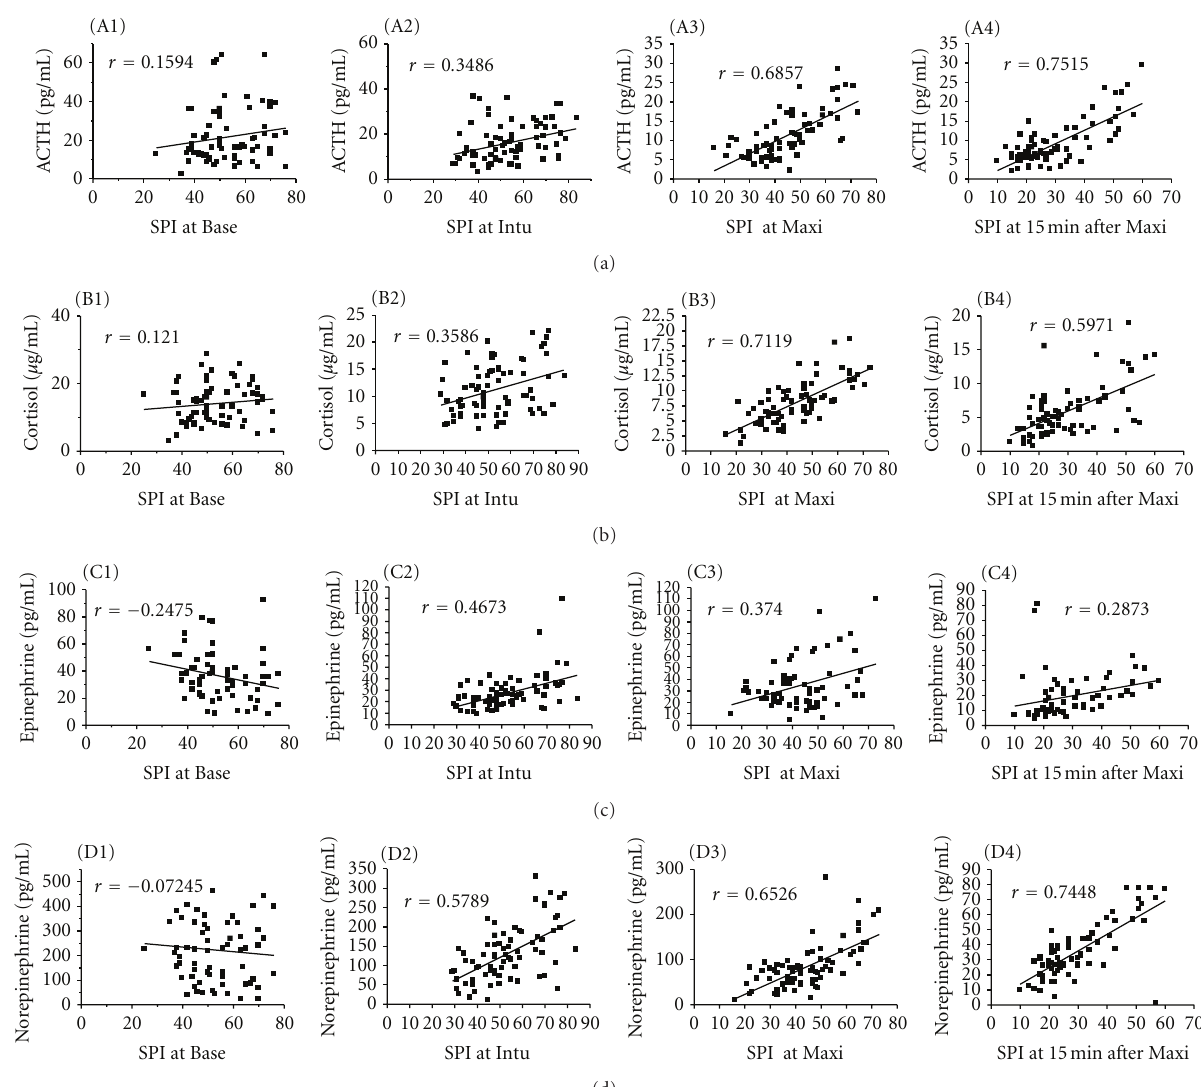
Figure 2: Linear regression analysis and correlation analysis between the SSI values and and stress hormones (ACTH, cortisol, epinephrine and norepinephrine). Bold line is regression line. Slopes of the above lines between time points are significantly di ff erent, P < 0 . 01. ACTH: adrenocorticotropic hormone; SPI: surgical pleth index; Base: baseline before anaesthesia; Intu: after tracheal intubation; Max: at maximum operative trauma, defined intraoperatively by the surgeon; After-Max: 15min after the maximum operative